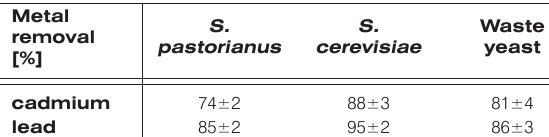
Table 1. The efficiency of the cadmium and lead removal by different yeast biomass. Metal